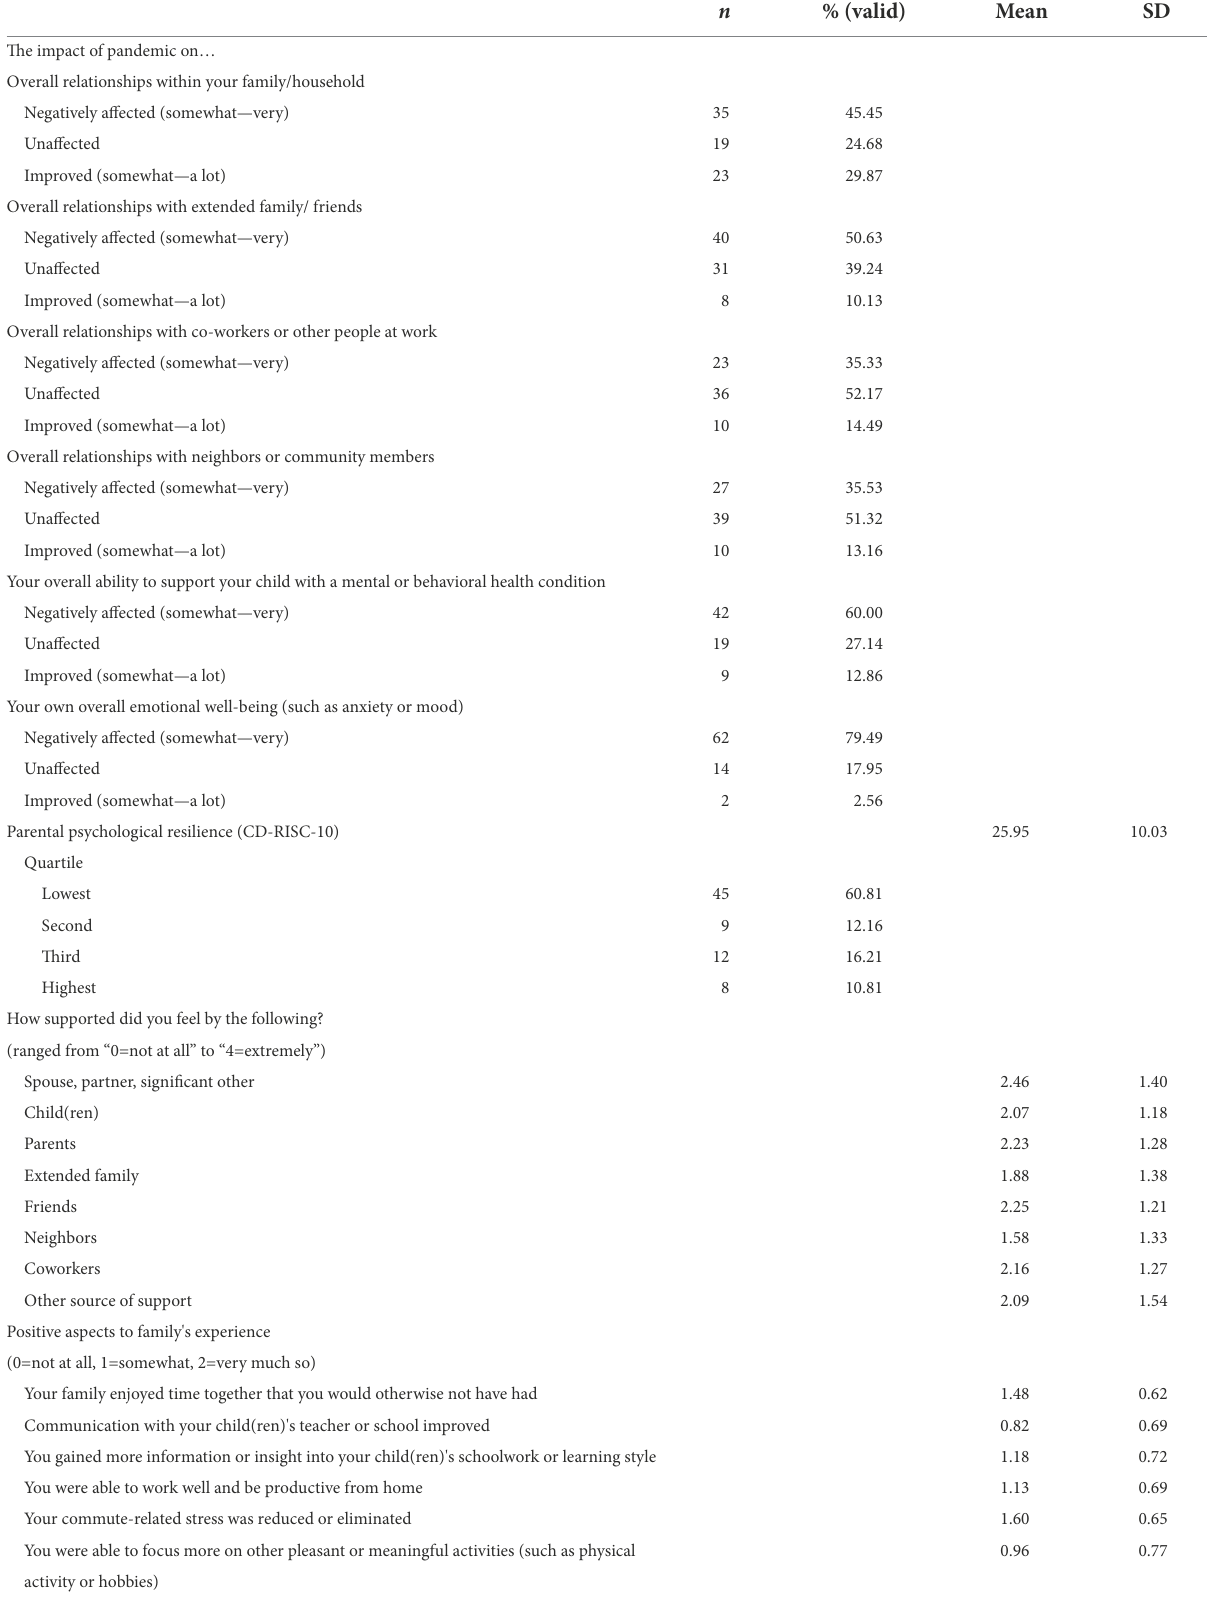
TABLE 2 Parent/guardian experience during the COVID-19